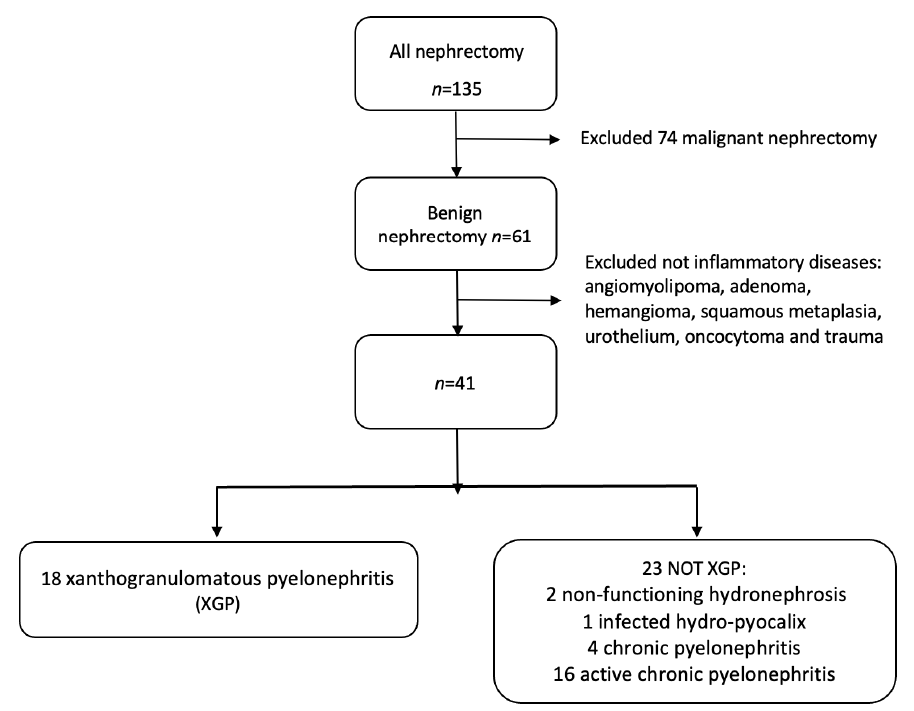
Figure 1. Flow chart of patients included in the study. Among them, 41 cases of inflammatory renal diseases were diagnosed: 2 non-functioning hydronephrosis, 1 infected hydro-pyocalix, 4 chronic pyelonephritis, 16 active chronic pyelonephritis, and 18 XGP.